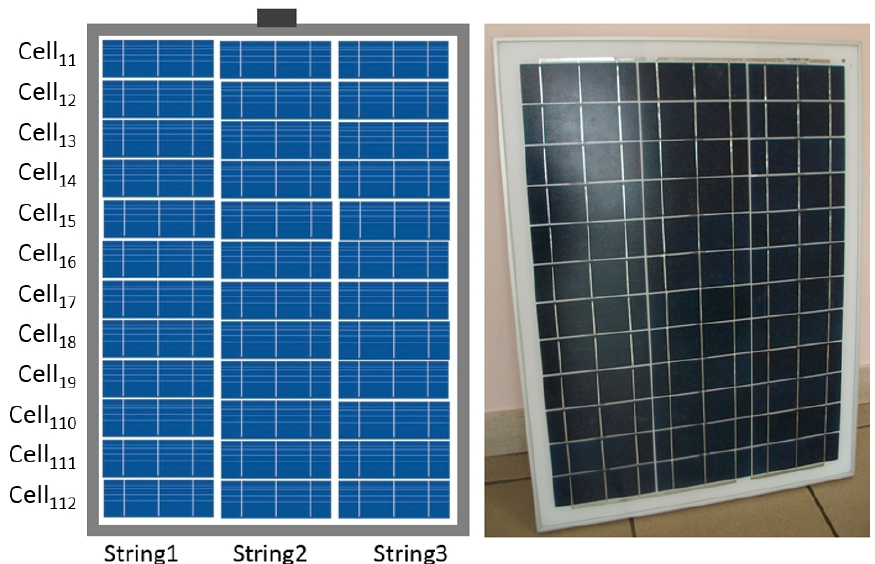
Figure 4. Identification of cells in the module ( left ) and picture of the real module ( right ).